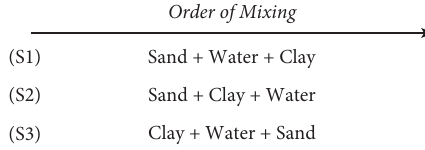
Figure 3: The three protocols for mixing sand, clay, and water.